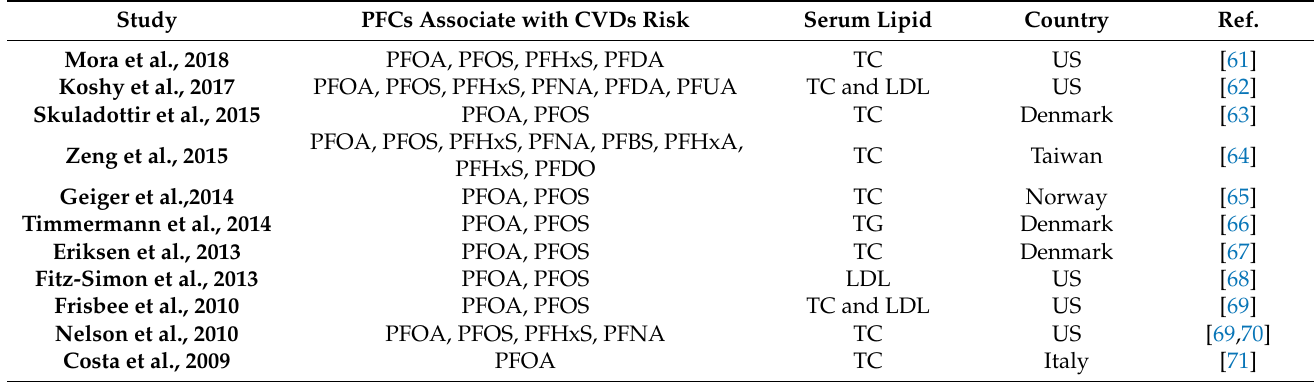
Table 2. Summary of PFCs exposure association with serum lipid profile as a CVDs risk